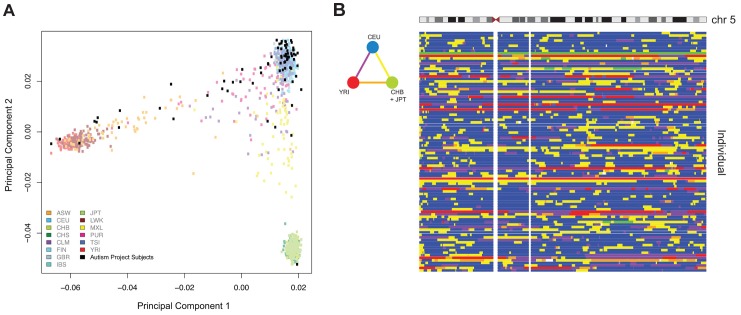
Principal components analysis (PCA) of ASD project genotypes with 1000 Genomes data and local ancestry deconvolution across chromosome 5. (A) Autism Project Subjects: We show 78 out of 95 non-founders in the cohort, after removing siblings for the PCA and keeping only one member per family. ASW: Americans of African Ancestry in SW USA; CEU: Utah Residents (CEPH) with Northern and West European ancestry; CHB: Han Chinese in Beijing, China; CHS: Southern Han Chinese; CLM: Columbians from Medellin, Colombia; FIN: Finnish in Finland; GBR: British in England and Scotland; IBS: Iberian population in Spain; JPT: Japanese in Tokyo, Japan; LWK: Luhya in Webuye, Kenya; MXL: Mexican Ancestry from Los Angekes USA; PUR: Puerto Ricans from Puerto Rico; TSI: Toscani in Italia; YRI: Yoruba in Ibadan, Nigeria. (B) The triangular color key denotes the color scheme used for genotype. Blue: Homozygous CEU; Green: Homozygous CHB+JPT; Red: Homozygous YRI; Yellow: Heterozygous CEU/CHB+JPT; Orange: Heterozygous CHB+JPT/YRI; Purple: Heterozygous YRI/CEU.